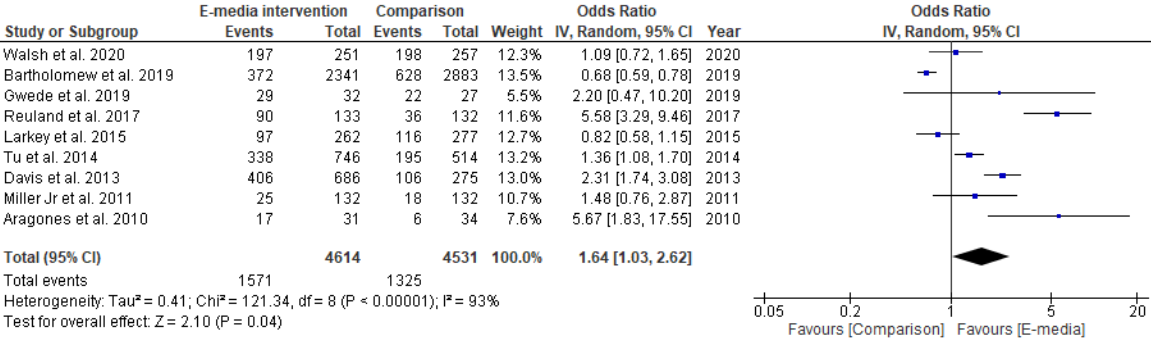
Figure 4. Random-effects forest plot for studies eligible for meta-analysis ( n = 9). Box size represents study weighting. Diamond represents overall effect size and 95% CI.